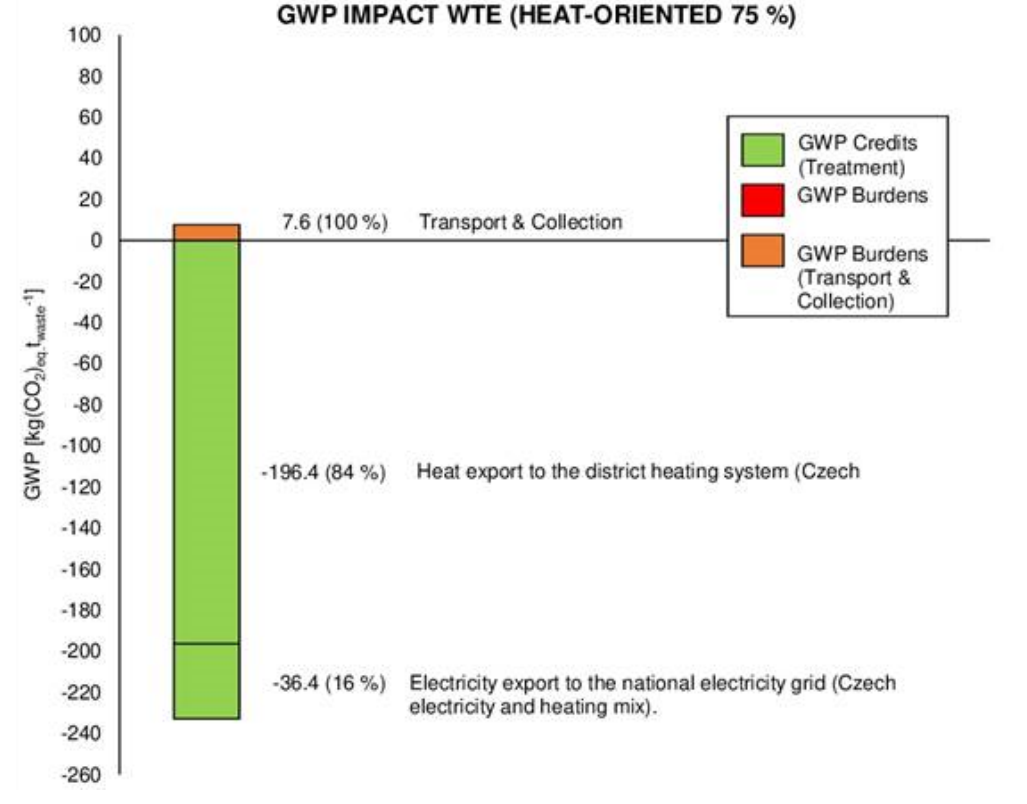
Figure 8. GWP impact of biowaste (SEP-BIO) incineration in WtE with heat production with CHP 75% of the maximum.